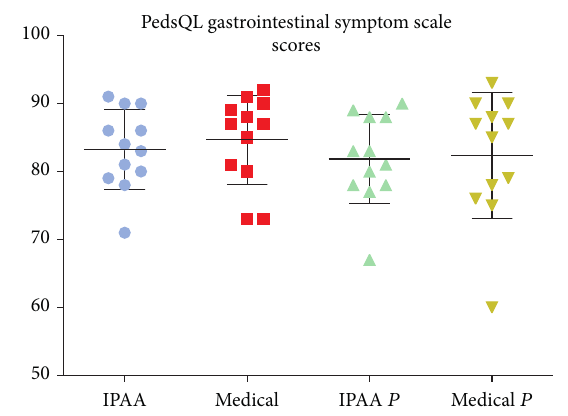
Figure 2: PedsQL-Gastrointestinal Symptom Scale scores in chil- dren receiving either surgical (IPAA, 𝑛 = 12 ) or medical (medical, 𝑛 = 12 ) therapy. The parents’ scores for the two groups are reported as IPAAp and medicalp, respectively. No differences were observed: IPAA versus medical, 0.83 versus 0.87 ( 𝑃 = 0.42 ); IPAAp versus medicalp, 0.82 versus 0.86 ( 𝑃 = 0.79 ); IPAA versus IPAAp, 0.83 versus 0.82 ( 𝑃 = 0.5 ); medical versus medicalp, 0.85 versus 0.82 ( 𝑃 = 0.62 ). IPAA: ileal pouch-anal anastomosis; p: